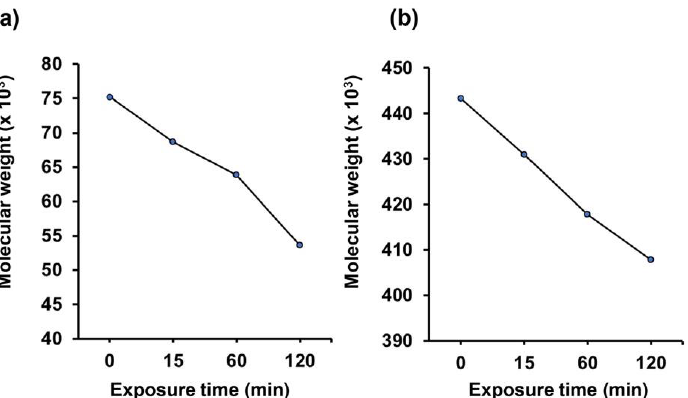
Figure 4. Effect of the exposure time to the air containing 16 ppm H 2 O 2 on the molecular weights of ( a ) Gelatin-Ph and ( b ) HA-Ph.